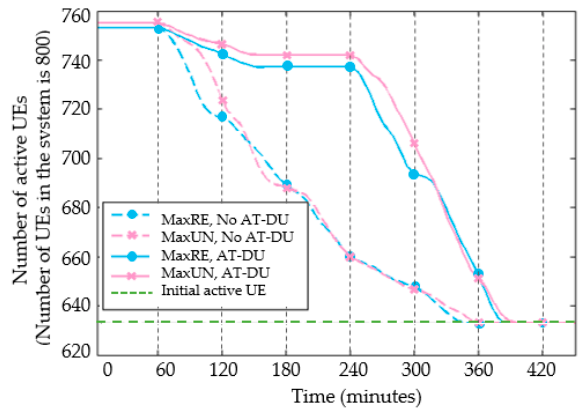
Figure 7. Comparison of active users over time.